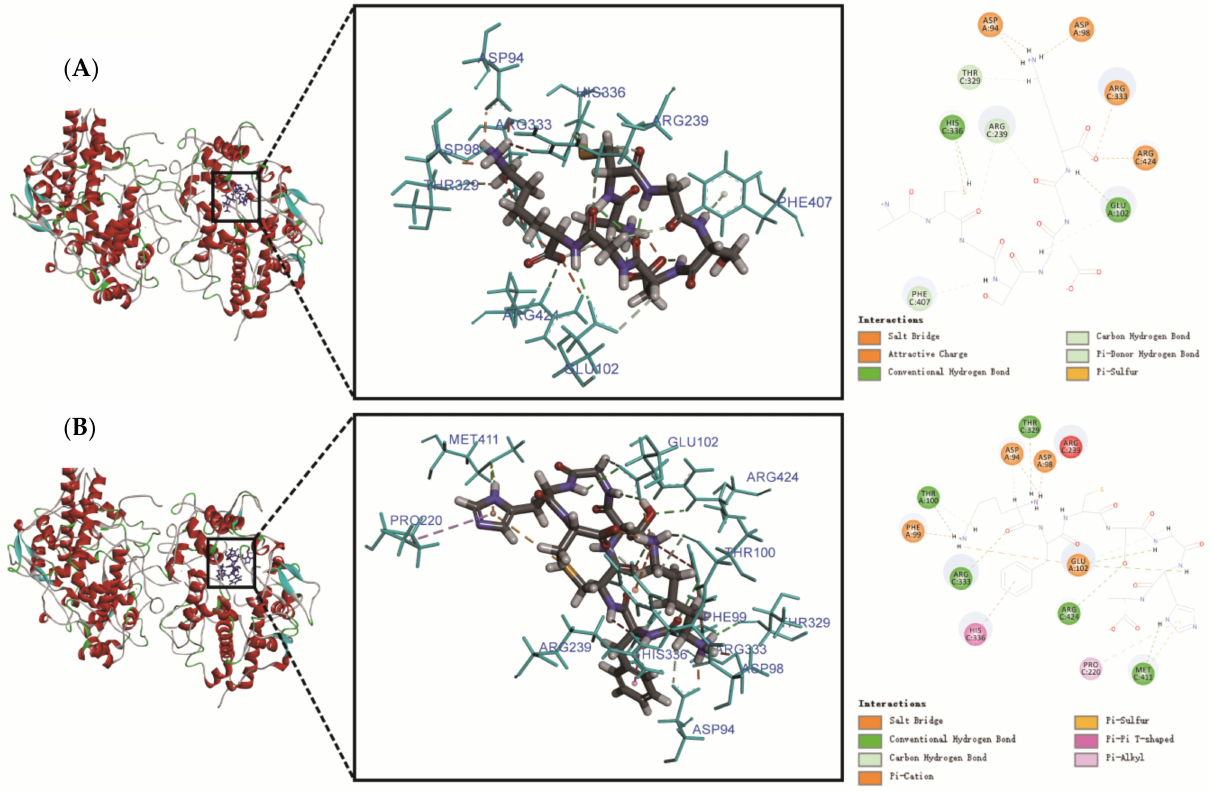
Figure 3. Three-dimensional and 2D structure graphs of the molecular interactions between peptide ACGSDGK ( A ) and MPO, as well as between peptide KFCSGHA ( B ) and